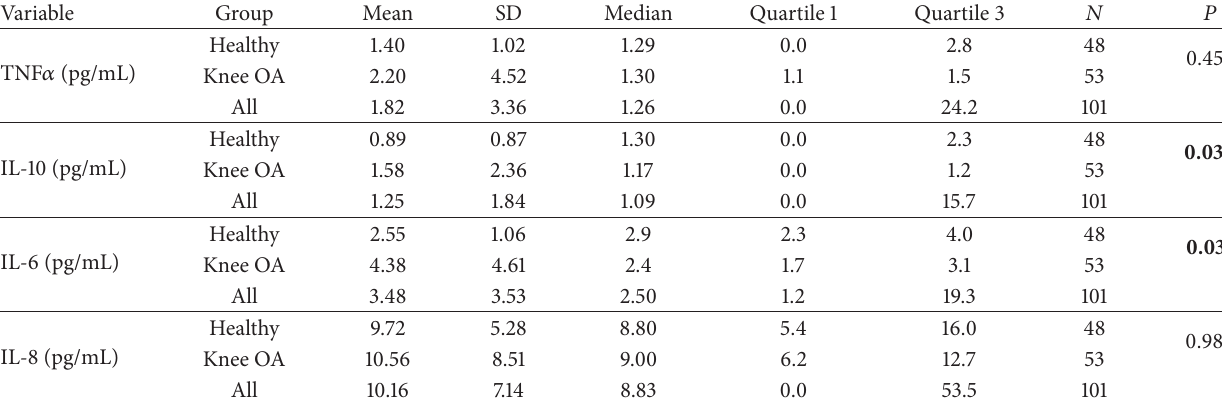
Table 3: Comparison of cytokine concentrations between